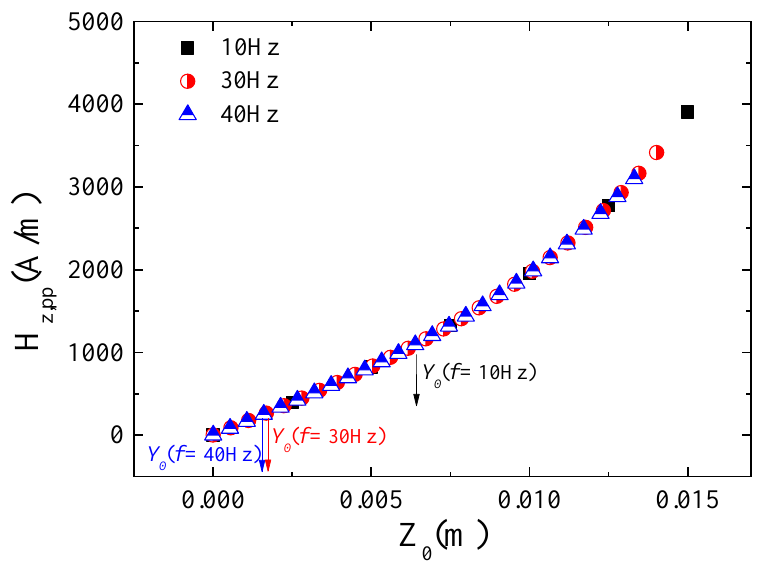
Figure 11. Theoretical magnetic field amplitude, H zpp , as a function of the harvester inertial mass displacement amplitude, Z 0 . The maximum experimental harvester amplitudes of vibration, Y 0 = 1.25 mm, are indicated.